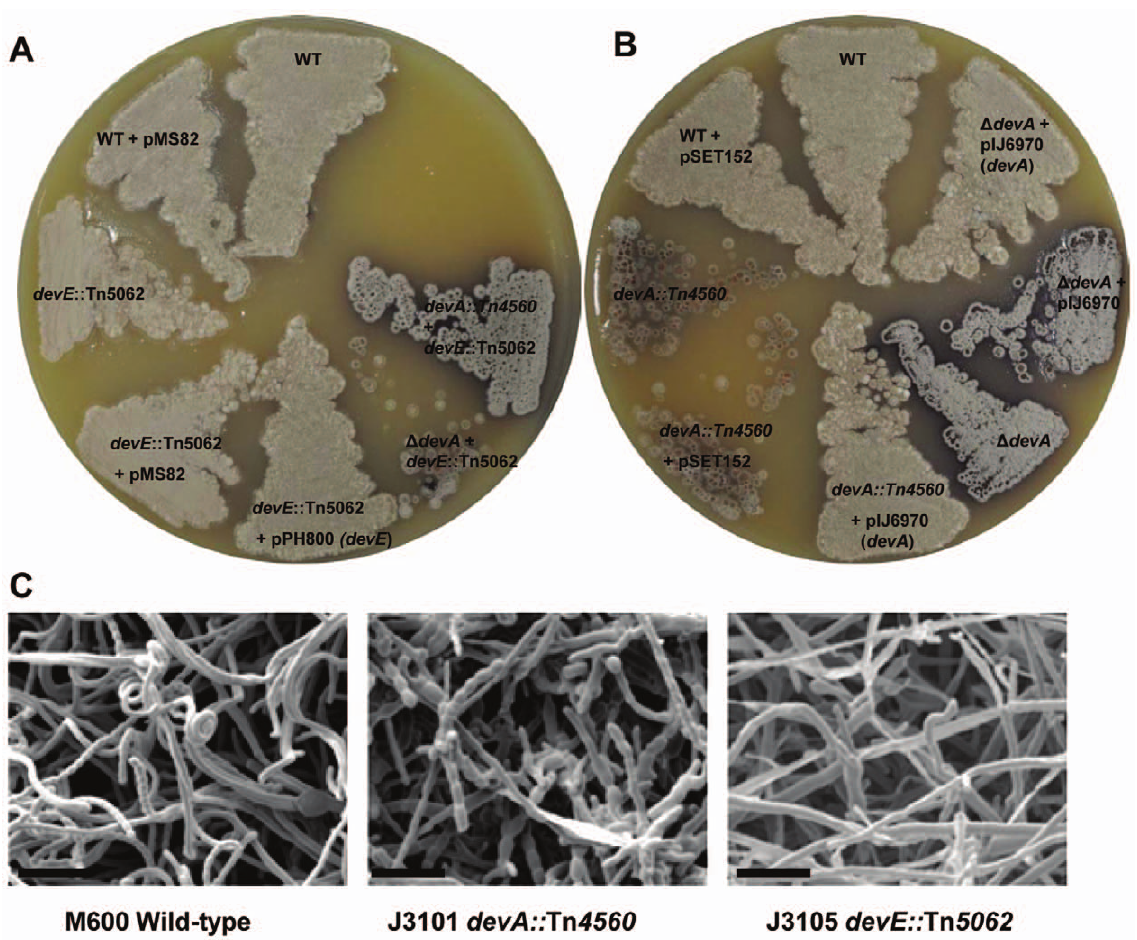
Figure 1. Deletion of devA or devE results in aberrant sporulation in Streptomycescoelicolor . A: Effect of devA & devE disruptions on colony appearance and complementation of mutants. Strains were grown on MS medium for 5 days. B: Scanning electron microscopy images of devA and devE mutants grown on MS medium. SEM Bar=10 m m.